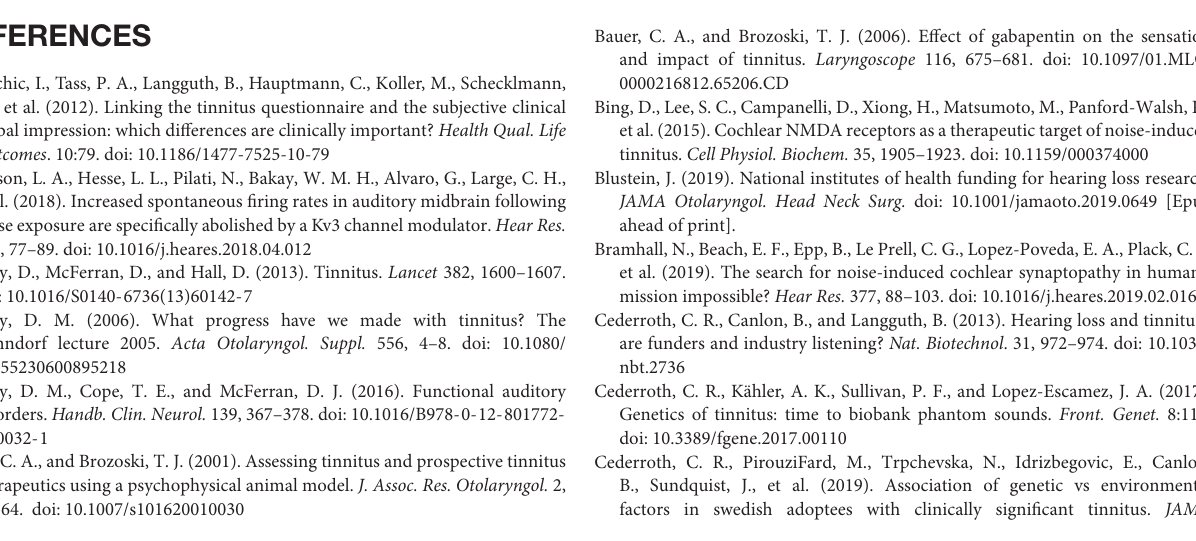
FIGURE S1 | The British Tinnitus Association Tinnitus Cure Map. A representation of tinnitus research areas. An interactive version accessed via the internet is being developed, demonstrating knowledge gaps but also demonstrating areas where we already know the answer and blind alleys that do not need further exploration. The interactive version will connect to other internet resources via hyperlinks. This version of the Cure Map uses four levels, which is the maximum number of levels envisaged for the paper version of the